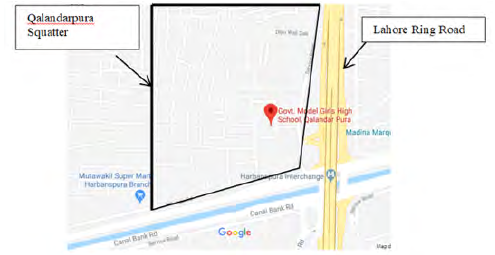
Figure 1. Google map for Qalandarpura squatter